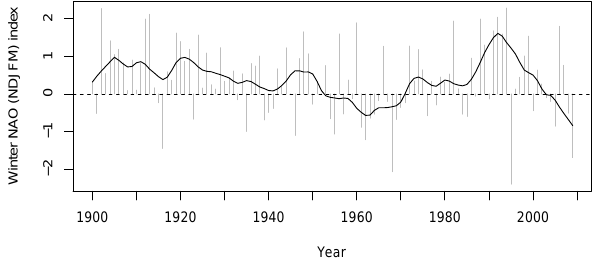
Fig. 3. Winter NAO indices based on standardized sea-level pressures differences from November to March – NAO (NDJFM) – between Iceland and Gibraltar from 1900 to 2009 (the year corresponds to November of each NDJFM average). The solid black line is a smoothing LOWESS